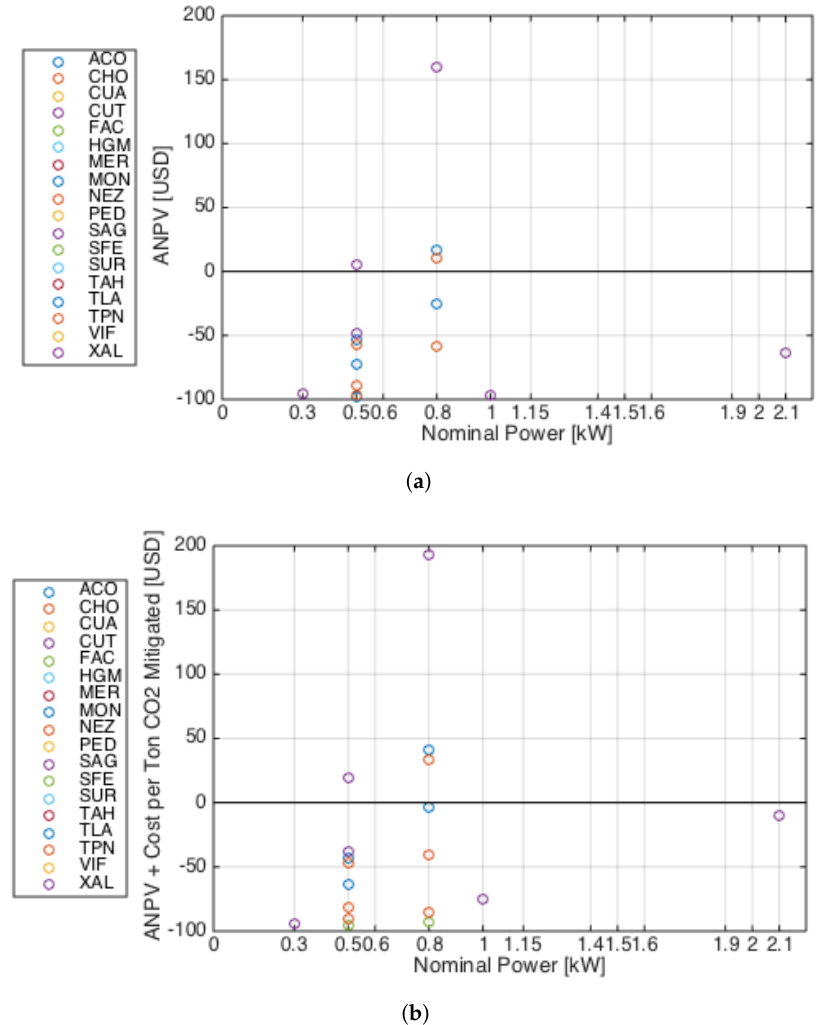
Figure 17. For each wind turbine, the cost per ton of CO 2 mitigated is calculated and added to the corresponding ANPV . In order to observe the effects of this addition, the original ANPVs for the SWTs with values that are closest to zero are plotted in ( a ). In ( b ), the same set of turbines and locations are plotted for the additional annual income. ( a ) Group of wind turbines with positive and ANPV values that are closest to zero; ( b ) Group of wind turbines with ANPV and particular income according to CO 2